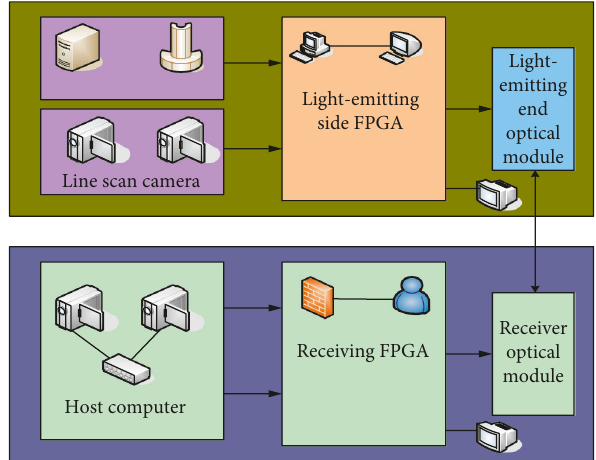
Figure 2: Image recognition and decoding process of dot matrix position